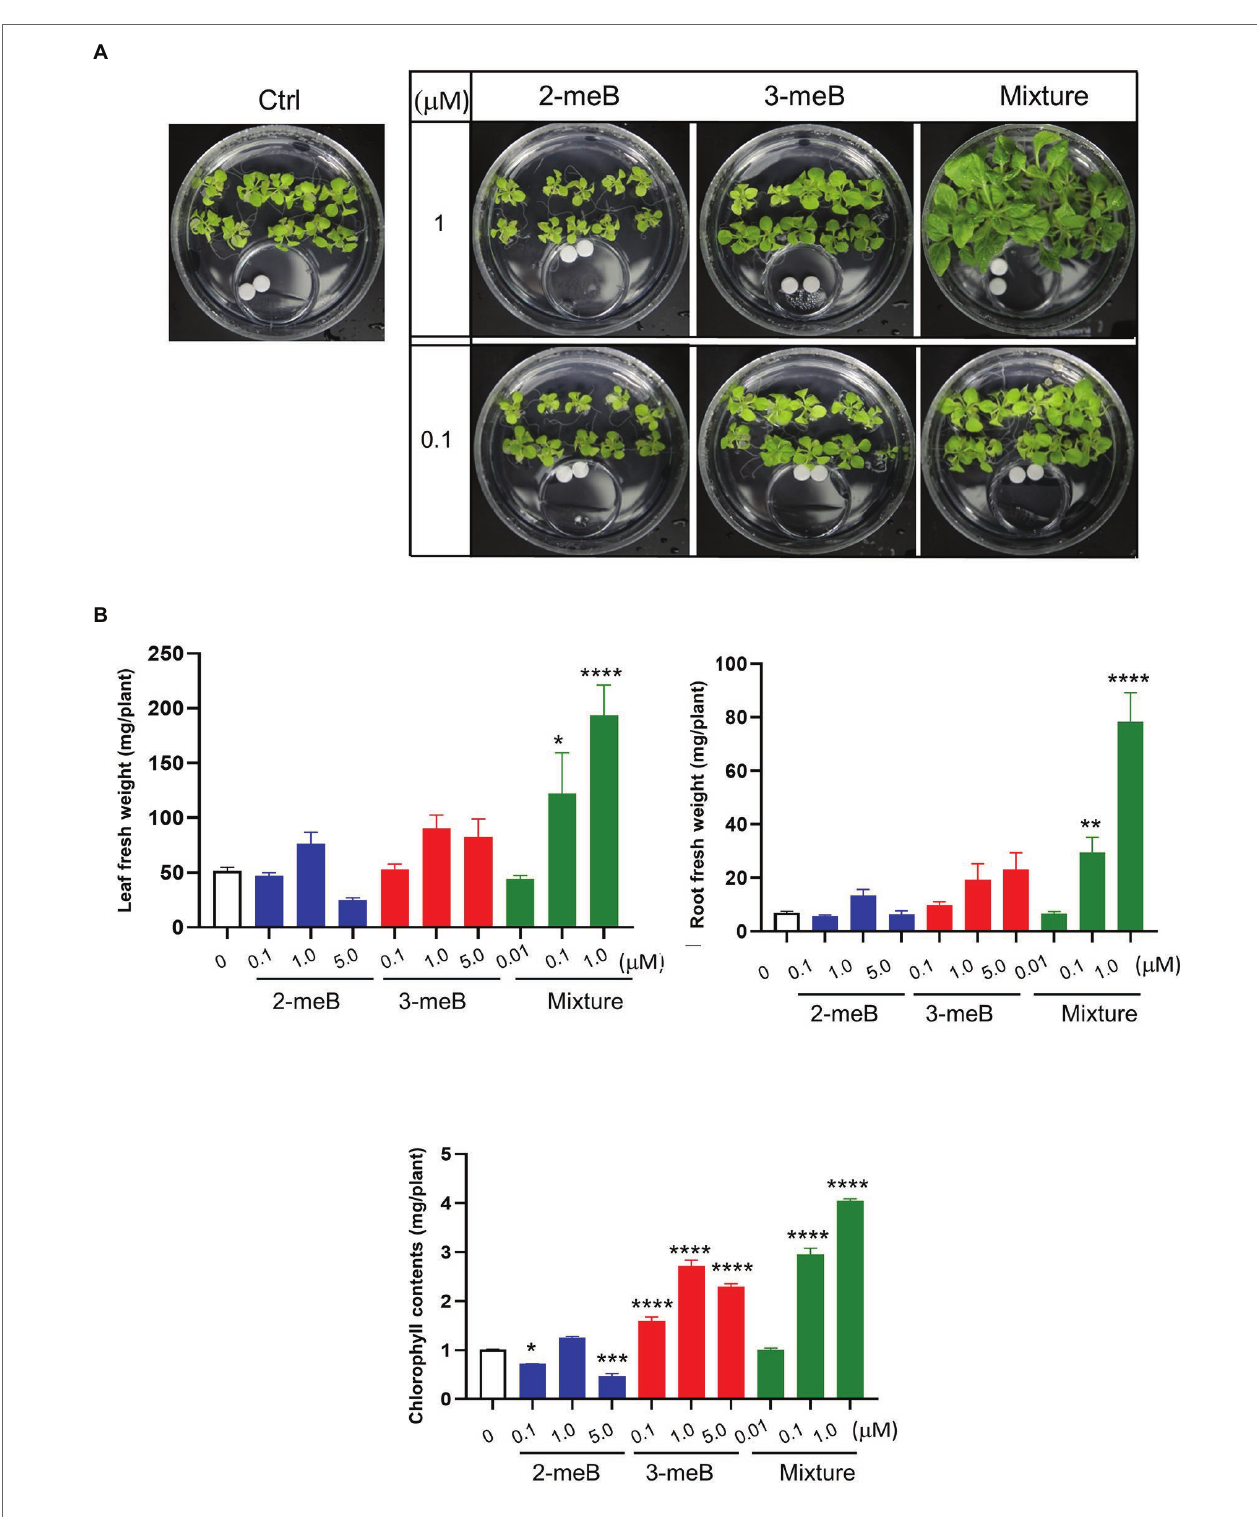
FIGURE 5 | Effects of different concentrations of 2-methyl-butanal and 3-methyl-butanal on growth of N. benthamiana. (A) Phenotypic characteristics of the plant after co-cultivation with 2-methyl-butanal and 3-methyl-butanal. (B) 2-methyl-butanal and 3-methyl-butanal regulate leaf fresh weight, leaf number, chlorophyll contents, root fresh weight, lateral root number, and root length. Error bars indicate the standard deviation of the mean ( n = 18). Experiments were repeated three times with similar results. Asterisks indicate significant difference among no treatment and each chemical exposure in different concentrations (One–way ANOVA, * p < 0.05, ** p < 0.01, *** p < 0.001, and **** p <